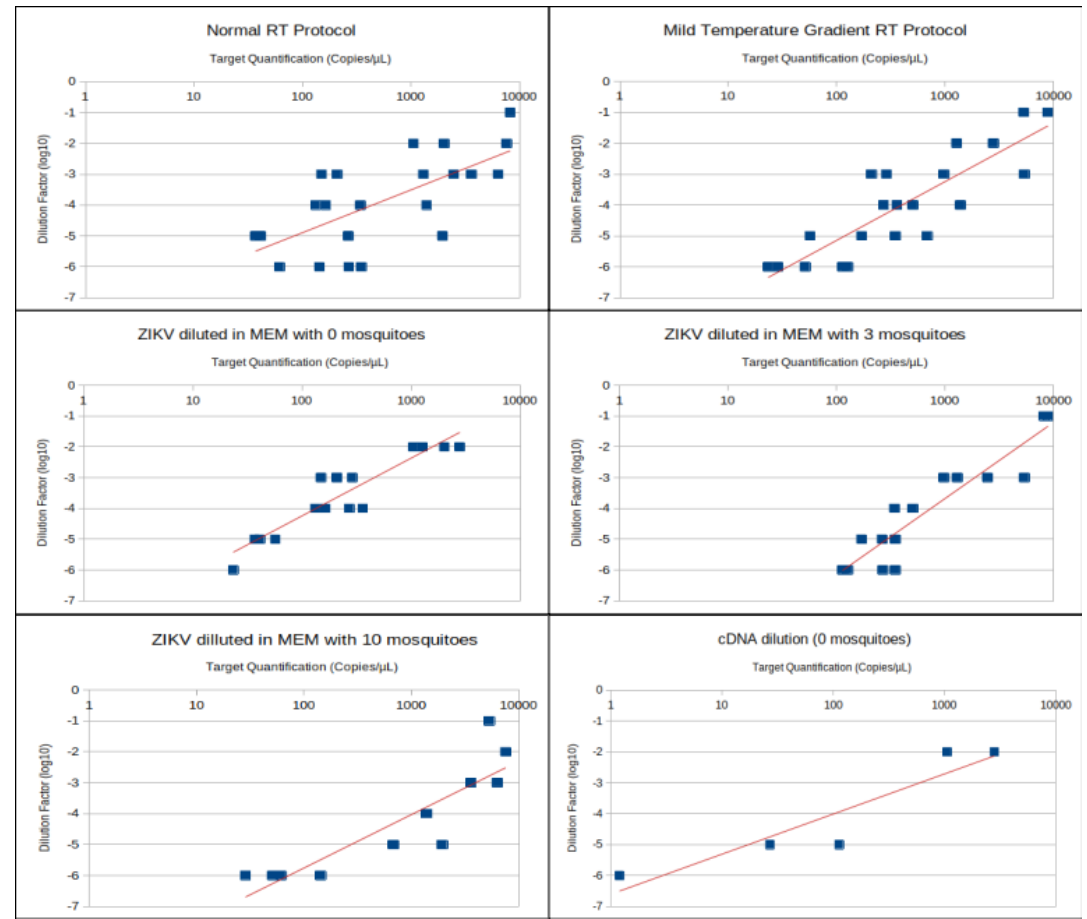
Figure 1. Dispersion charts with trend lines correlating dilution factors in log 10 and viral quantification (logarithmic scale) for different samples and sample treatments. Results from milder temperature gradient (MTG) and normal reverse transcription (RT) protocols were pooled to create the panels of 0, 3 and 10 mosquitoes.